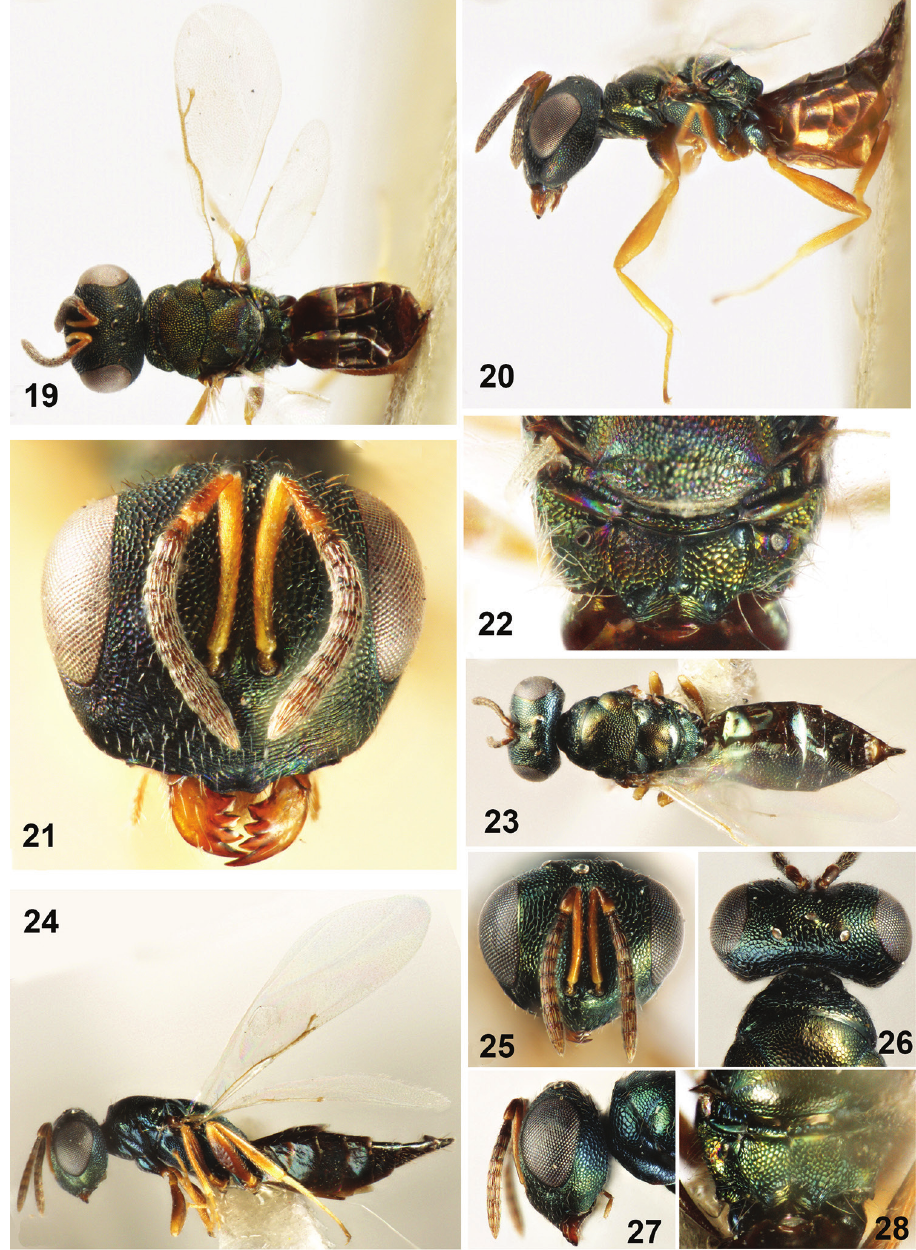
23 Body in dorsal view 24 Body in lateral view 25 Head in frontal view 26 Head in dorsal view 27 Head in lateral view 28